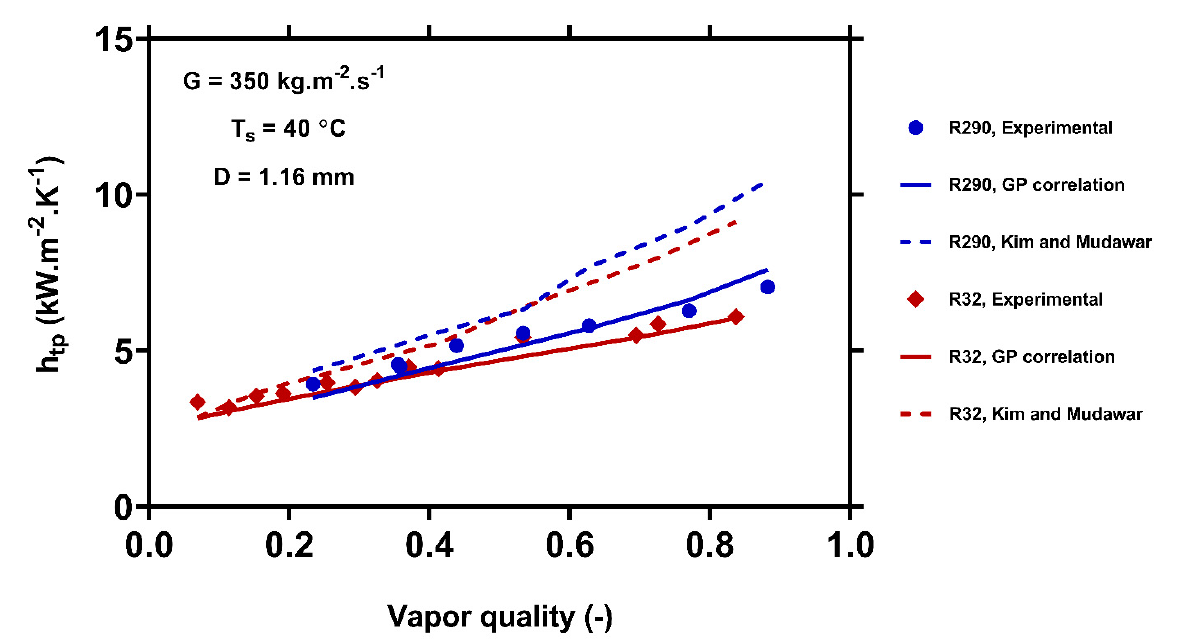
Figure 7. Comparison of the predictions of the GP correlation (Equation (13)) and the model of Kim and Mudawar [52] with the experimental data [73,76] for R290 and R32 condensing at the mass flux of 350 kg · m − 2 · s − 1 and saturation temperature of 40 °C inside a 1.16 mm channel. Blue and red points represent the R290 and R32, respectively. The solid points, solid lines, and dash lines represent the experimental values, GP outcomes, and Kim and Mudawar [52] outcomes, respectively.